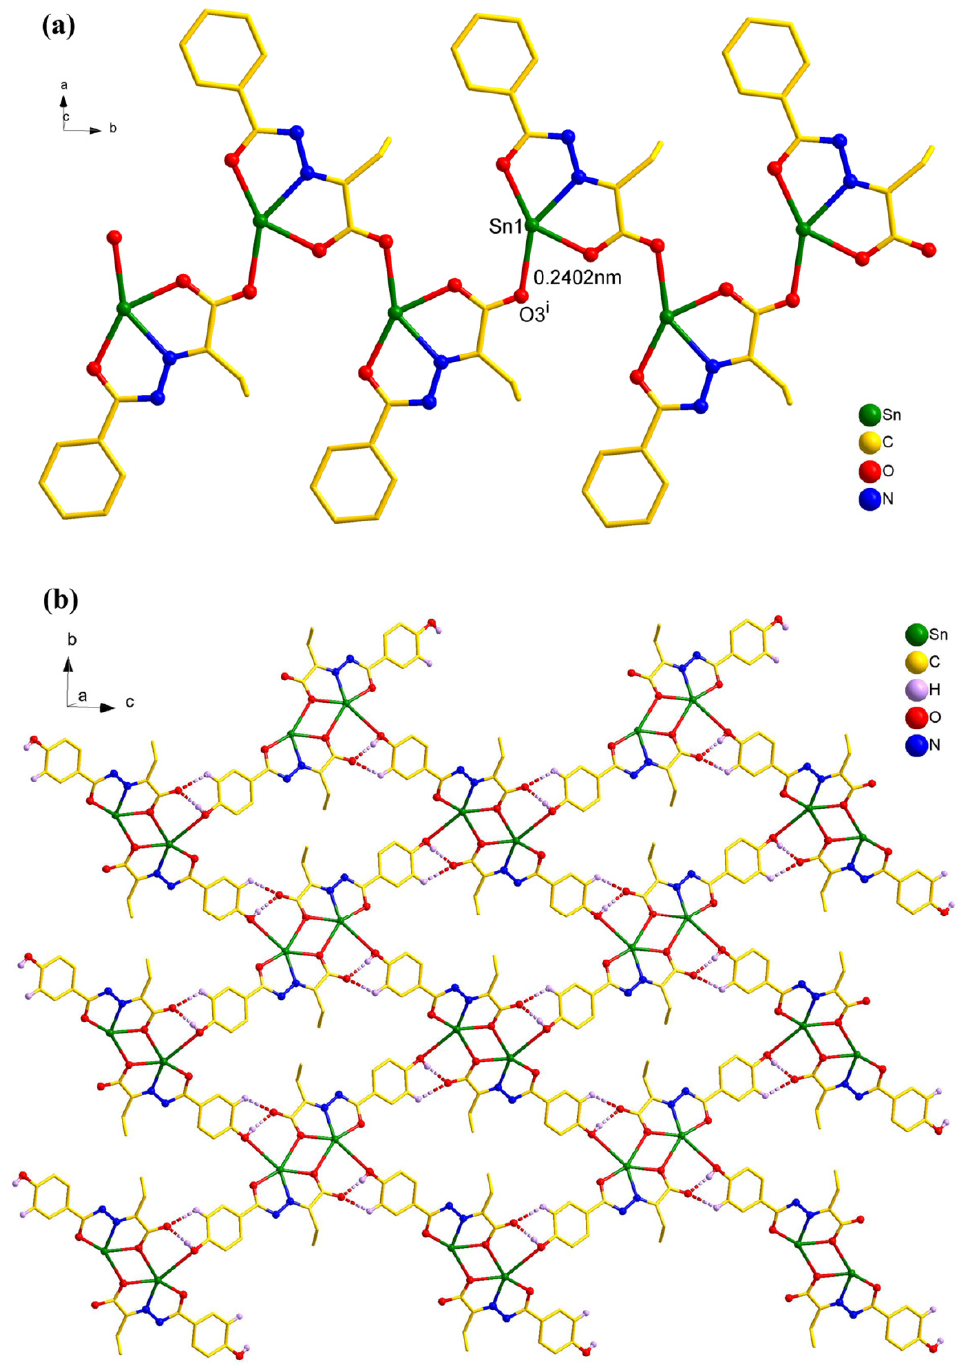
Figure 2. 1D or 2D structures. ( a ) One-dimensional chain structure of complex 1a , (two phenyl groups on the tin atom have been omitted for clarity). ( b ) Two-dimensional network structure of complex 3b , (two butyl groups on the tin atom have been omitted for clarity).